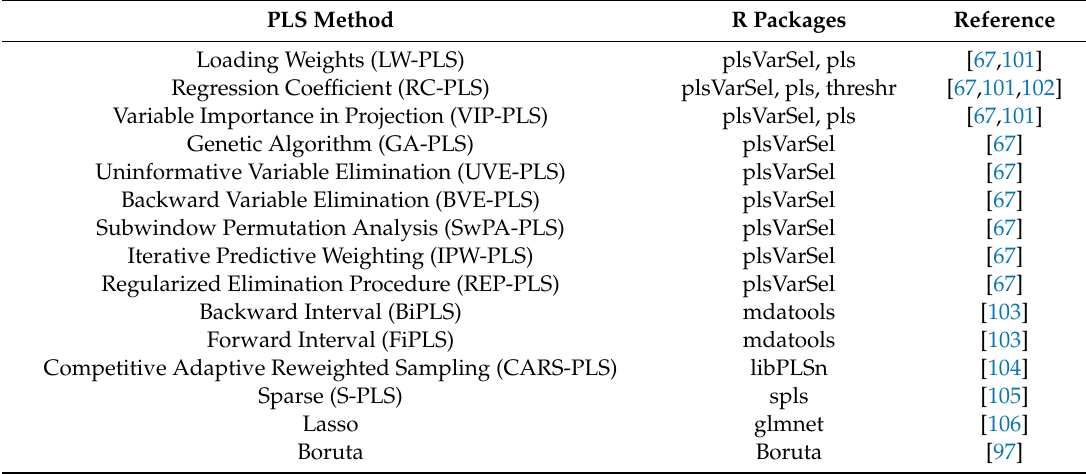
Table 3. R packages used for wavelength selection methods.